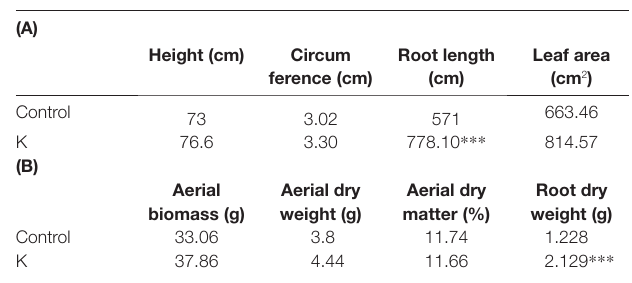
TABLE 2 | Effect of Mucilaginibacter sp. K on the growth parameters (A) and biomass (B) of maize plants at 35